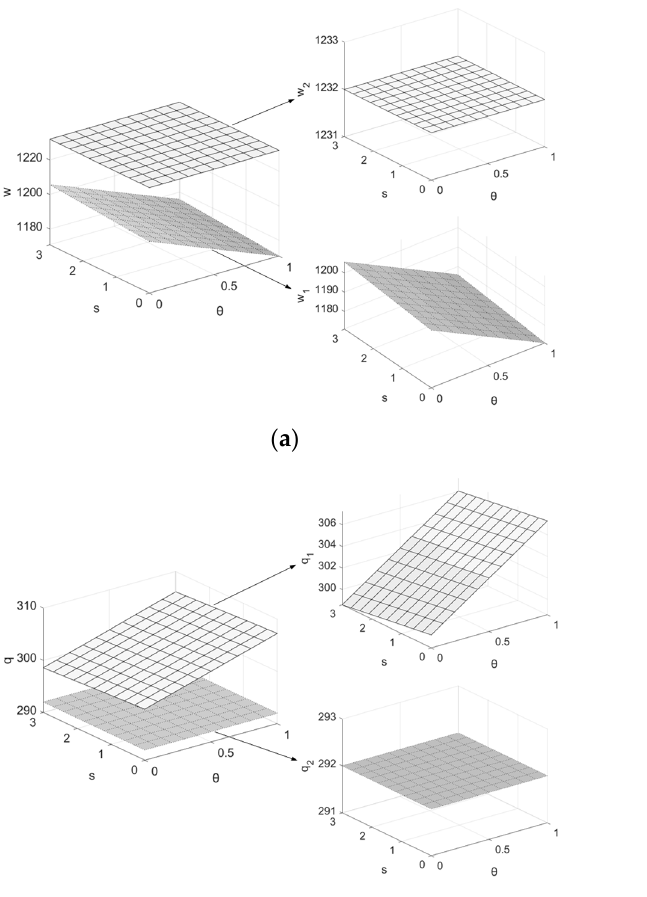
s θ Figure 4. Effects of θ and s on decision variables. ( a ) Effects of θ and s on w 1 , w 2 ; ( b ) effects of θ and s Figure 4. Effects of and on decision variables. ( a ) Effects of on p 1 , p 2 ; ( c ) effects of θ and s on q 1 , q 2 ; ( d ) effects of θ and s on π m , π r , π . , p p , q q s s θ θ and on 1 2 ; ( c ) effects of and on 1 2 ; ( d ) effects of